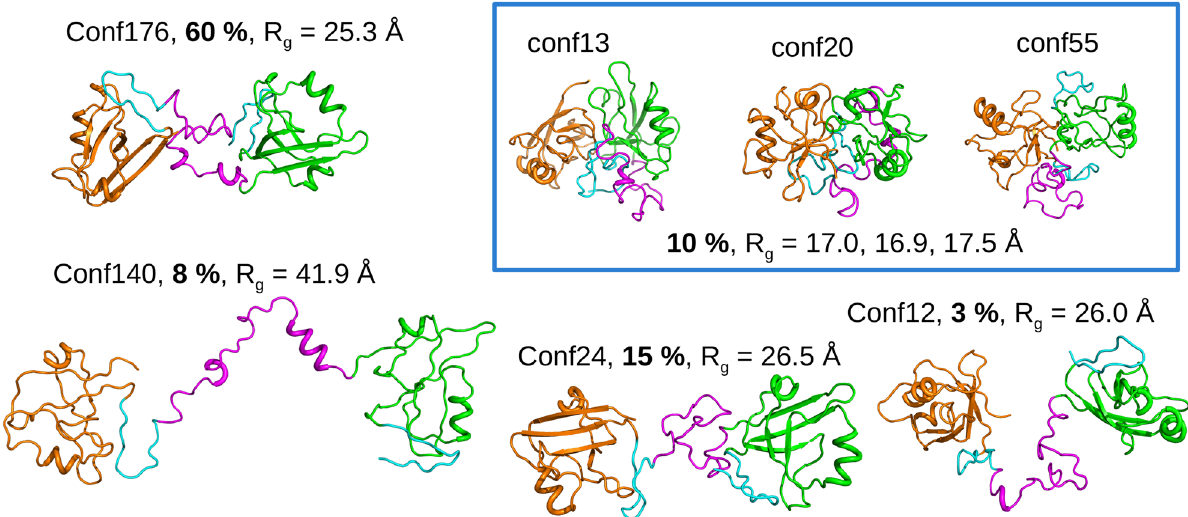
Figure 3. Overview of the P1LnkP2 conformations selected by BioEn 0.1.1 37 . The conformation indexes are given along with the populations obtained by SAXS curve fitting in bold, and with the gyration radius REV2NUMB6 ( R g ). The most closed P1LnkP2 conformations, for which it was not possible to determine the individual populations from the fitting of SAXS data, are plotted within a frame. The conformations were drawn using pymol 1.8.4.0 59 .